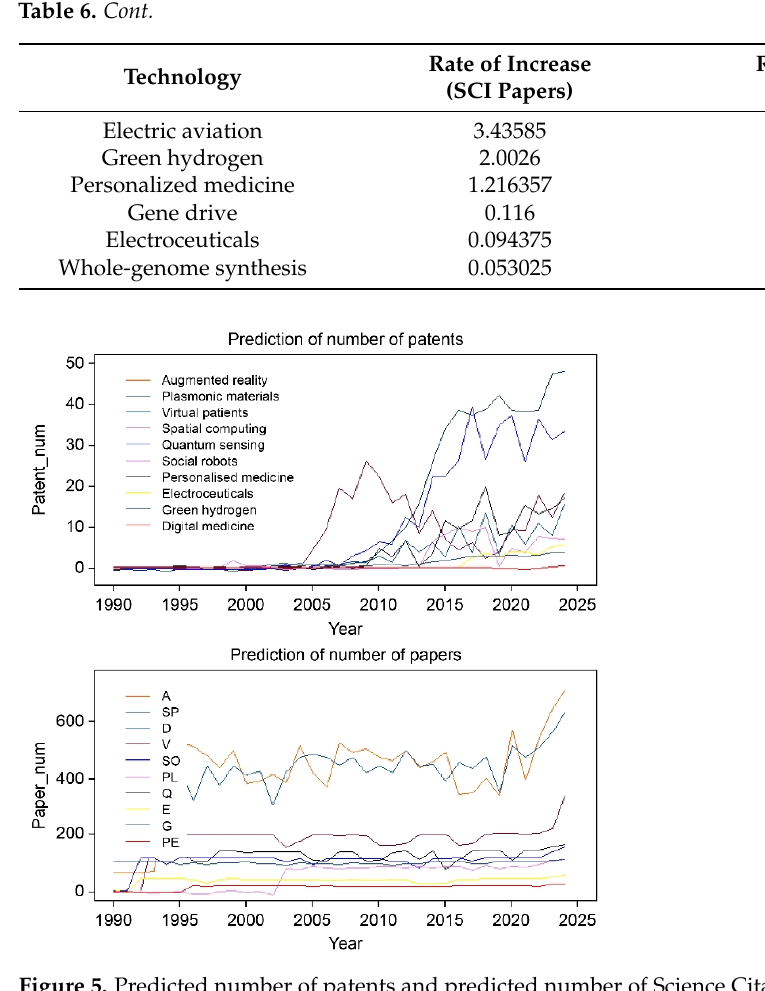
Figure 5. Predicted number of patents and predicted number of Science Citation Index (SCI) papers for ten derived future promising technologies: A, SP, D, V, SO, PL, Q, E, G, and PE refer to “Augmented reality,” “Spatial computing,” “Digital medicine,” “Virtual patients,” “Social robots,” “Plasmonic materials,” “Quantum sensing,” “Electric aviation,” “Green hydrogen,” and “Personalized medicine,” respectively. In the patent number prediction graph, the number of patents in augmented reality exceeded 1000 and it did not appear in the graph. The graph of the predicted number of patents for augmented reality technology is shown in Figure 4.